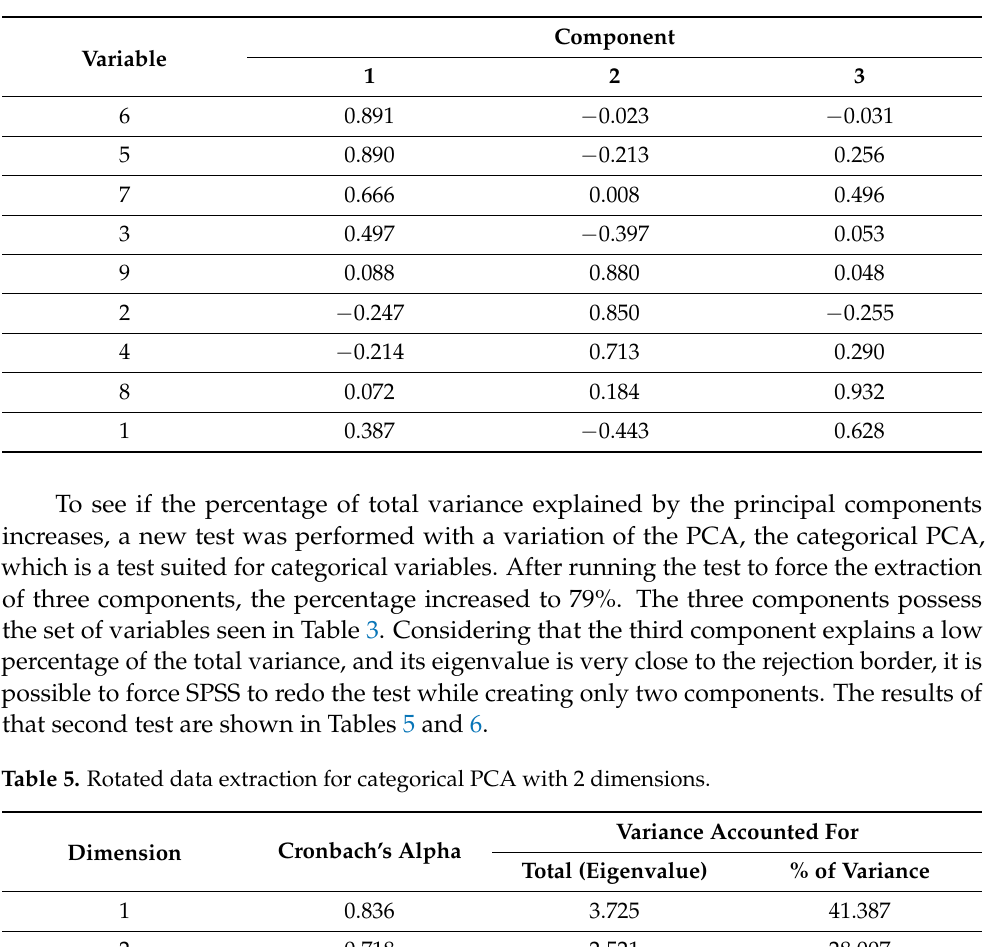
Table 4. Rotated component matrix.